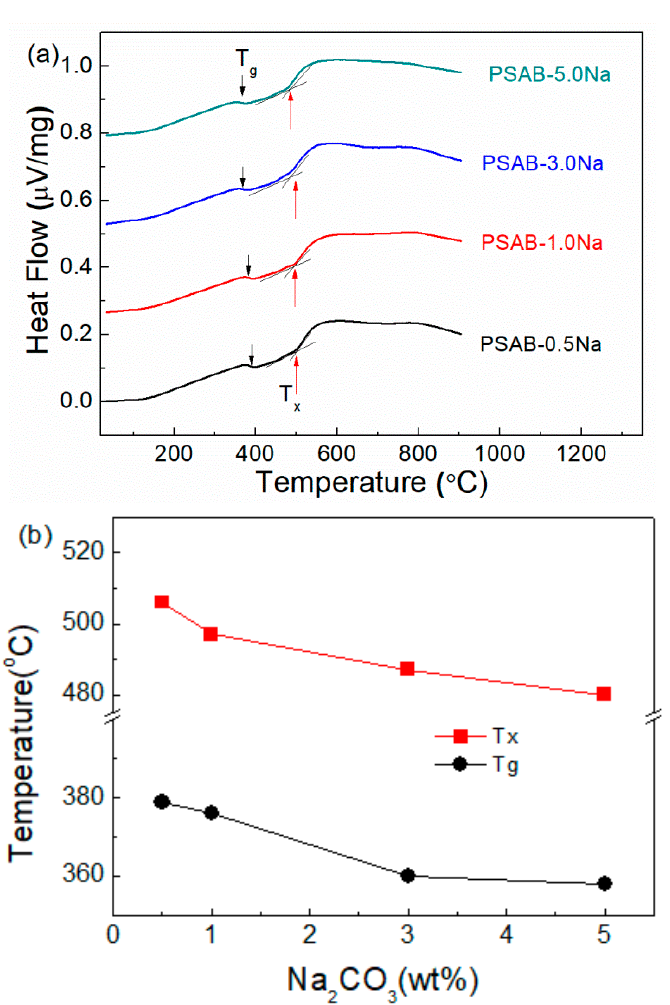
Figure 3. ( a ) The DTA traces; and ( b ) variation of T g and T x as a function of Na 2 CO 3 concentration in the PSAB glass system.